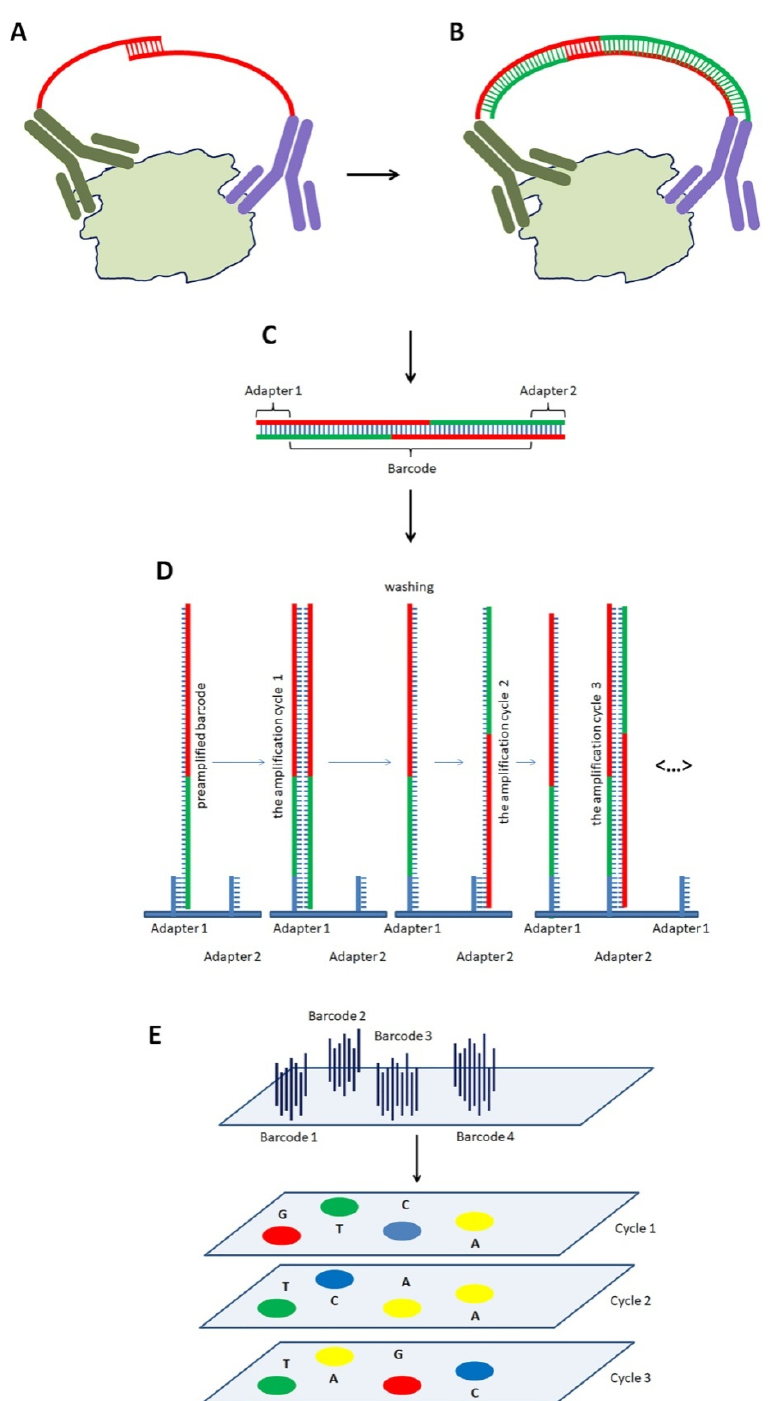
Figure 6. The Proximity Extension Assay. The experiment includes several steps. ( A ). Immunoassay (Step 1). The pairs of specific antibodies conjugated with ssDNA oligonucleotides specifically interact with target proteins. As both ssDNA contain short complementary sequences, they interact and form a duplex in the middle. ( B ). Extension of ssDNA (Step 2). The duplex serves as a set of primers to DNA polymerase that extends ssDNA to dsDNA. ( C ). A cleavage of dsDNA (Step 3). Cutting dsDNA from the antibodies produces an oligonucleotide. Each oligonucleotide contains a unique sequence that serves as a barcode to identify the target protein. It also has two short adapter sequences at the ends. ( D ). Preparation for the sequencing of the barcodes (Step 4). The obtained dou- ble-stranded oligonucleotides are denatured and interact with immobilized probes complementary to the adapters. Then, DNA polymerase amplifies DNA using the probes as primers. ( E ). Clusteri- zation of DNA and sequencing the barcodes (Step 5). As the concentration of DNA is relatively low,